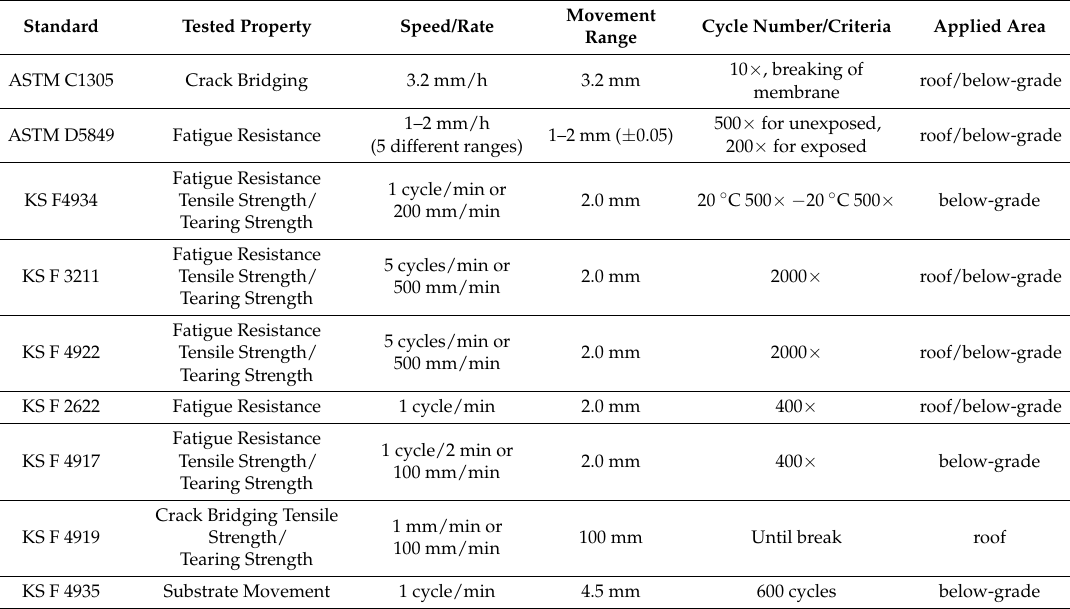
Table 3. Joint displacement range, speed, and cycle number conditions in ASTM and KS.